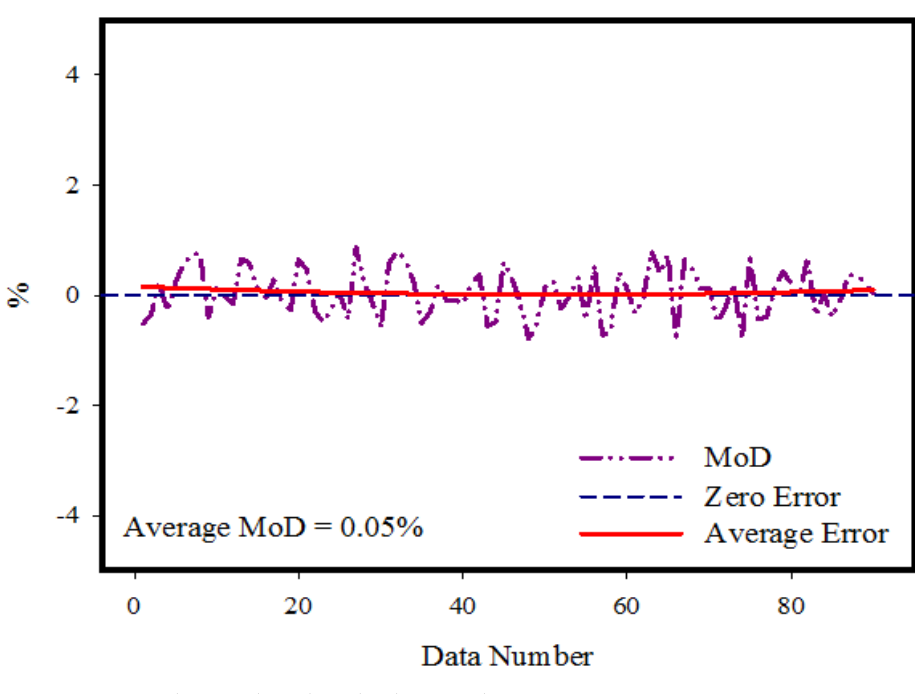
Figure 9. MoD values are based on the data number.